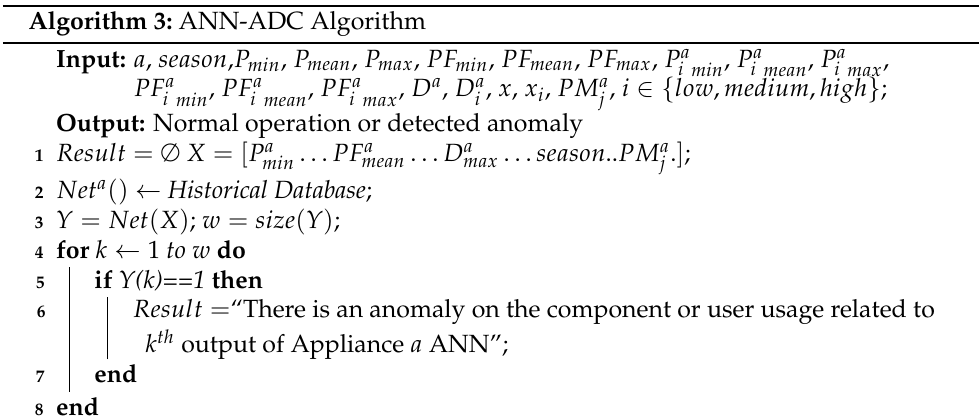
Algorithm 3: ANN-ADC